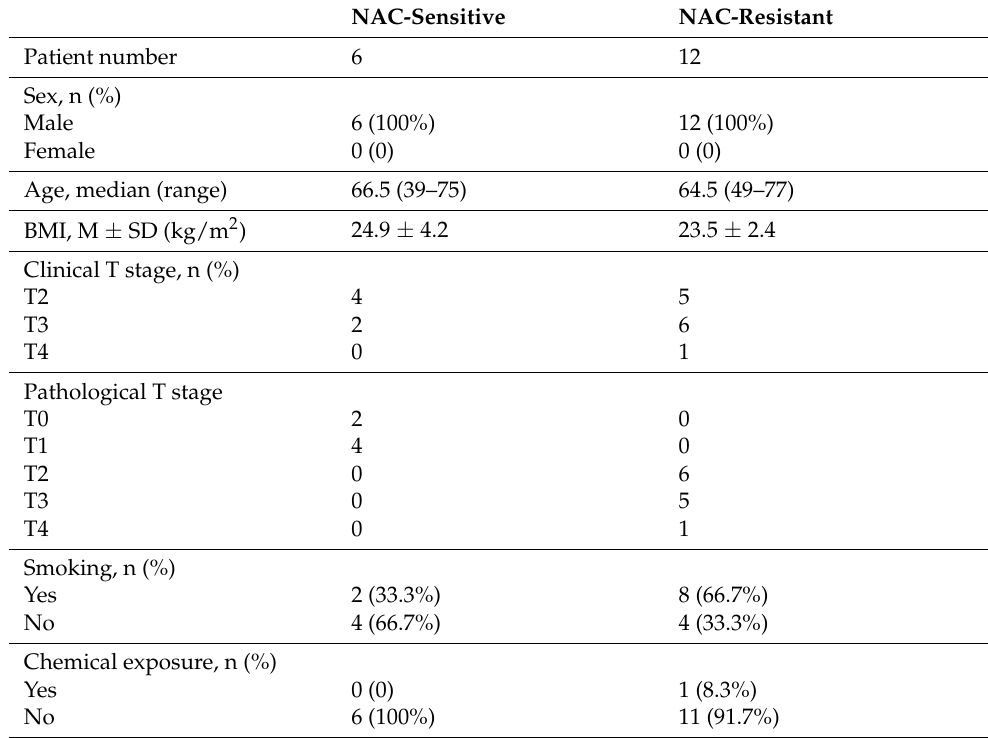
Figure 1. Typical 500 MHz 1 H-NMR spectra of serum for the two groups. Red spectra represent NAC-resistant group and black spectra represent NAC-sensitive group. Table 1. Patient baseline